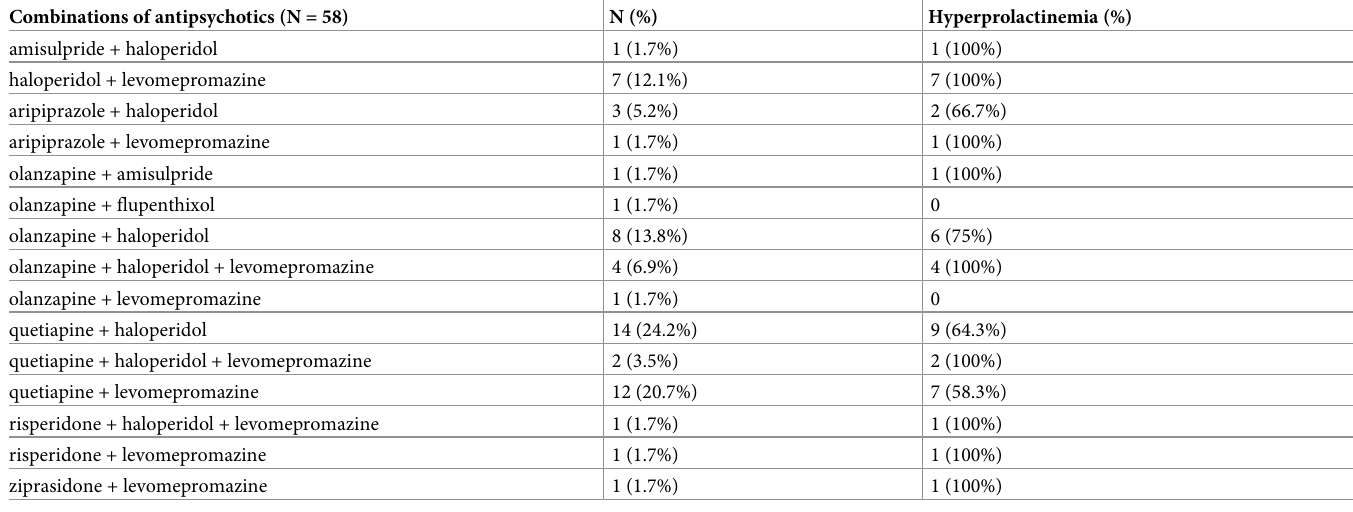
Table 4. Combinations of antipsychotics and